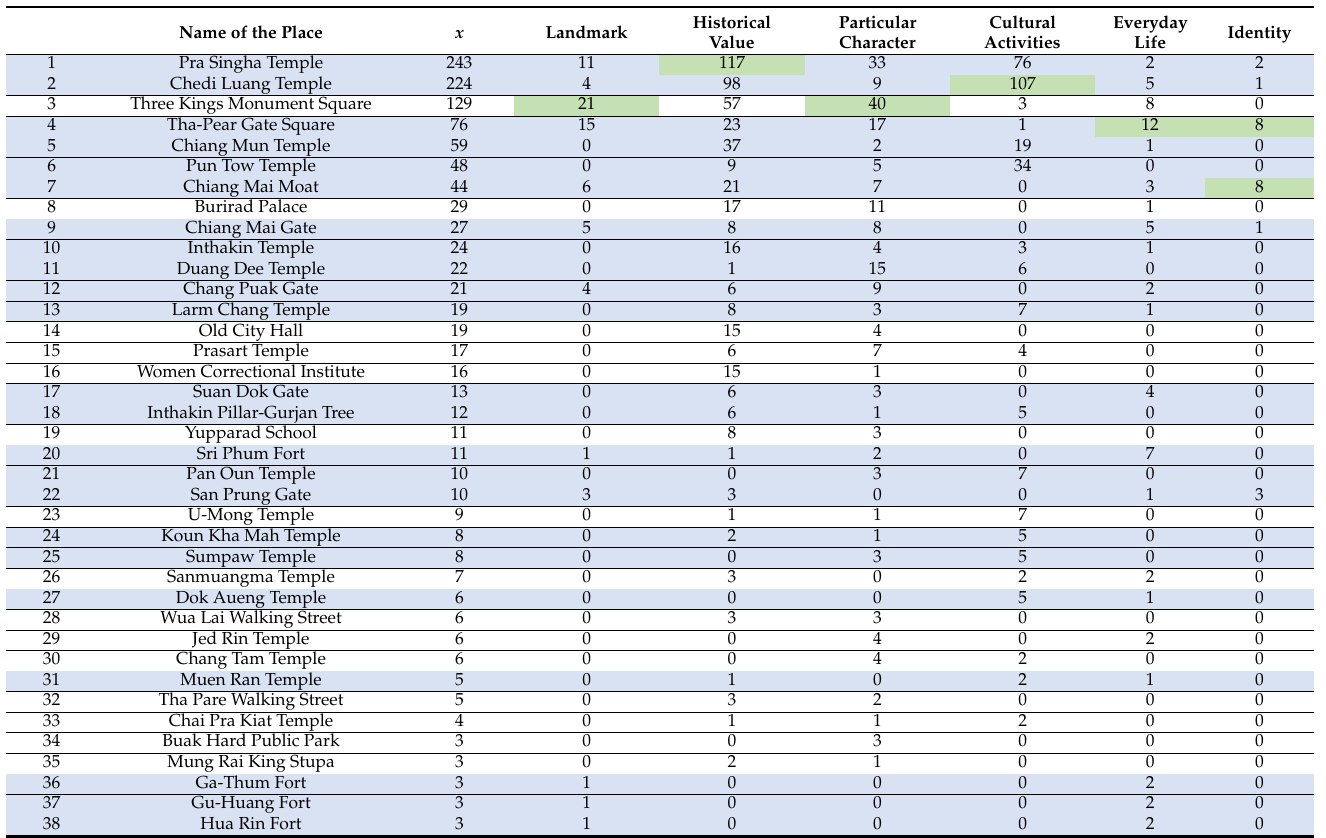
Table 5. The conclusion of the recalled to the important places in Chiang Mai Old